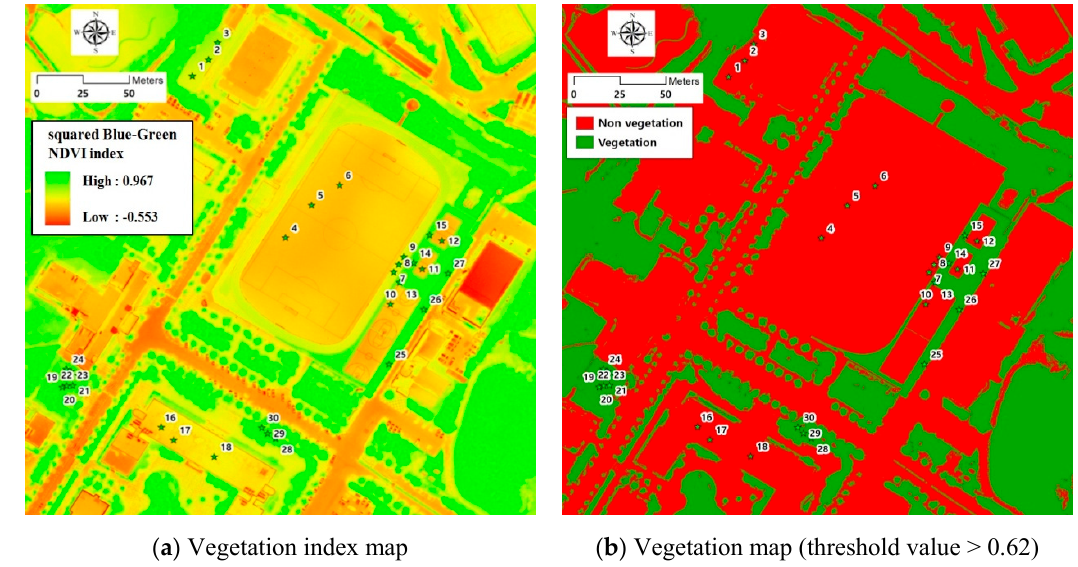
Figure 8. Vegetation index map and vegetation map based on the squared Blue-Green Normalized Difference Vegetation Index (NDVI) index.